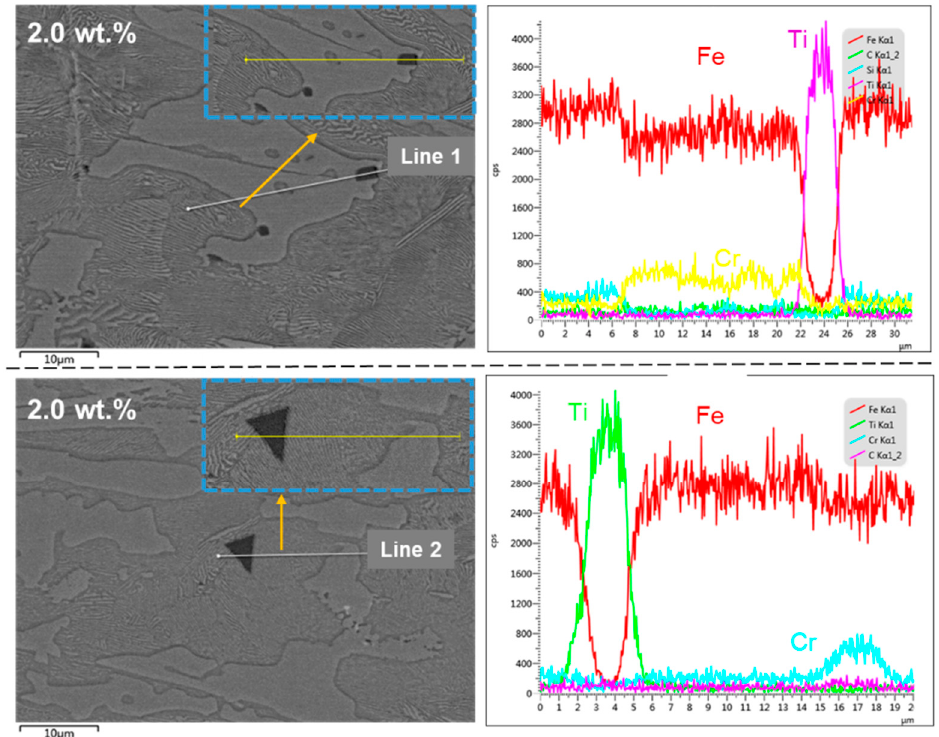
Figure 6. Distribution of TiC particle in the matrix of medium chromium cast iron with 2.0 wt.% Ti 3 AlC 2 additive.